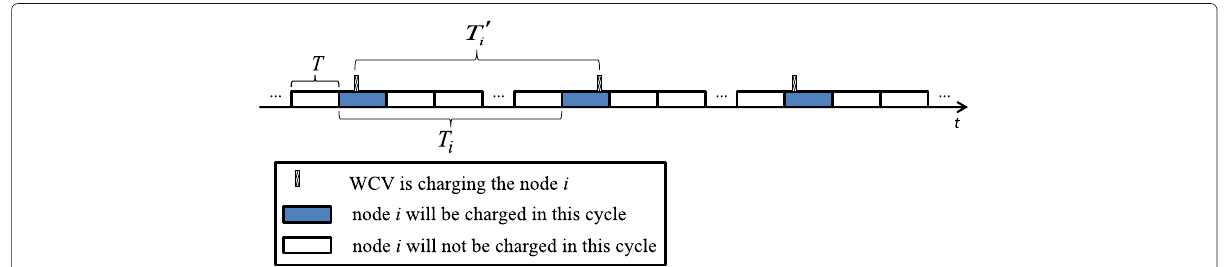
Fig. 2 The charging period of node i in WSN. For each node i , the MCV charges i periodically with a mean period time of T i . T i is set to be an integral multiple of T . The blue and white blocks indicate that i will be charged and not be charged in this cycle, respectively. T i (cid:3) is the visiting and charging interval of i , which is defined and explained detailly in the discussion